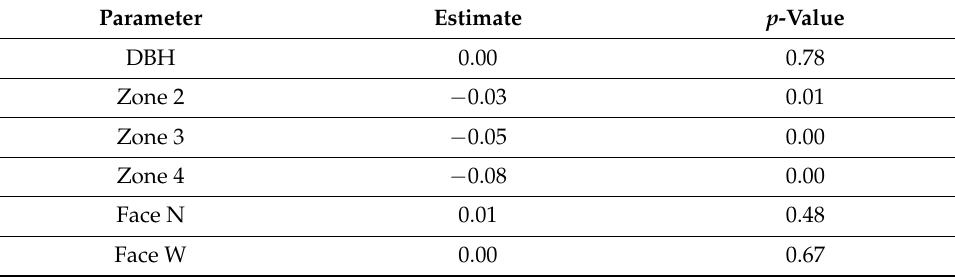
Table 3. Parameters tested in the Linear Mixed Model and its signaificance